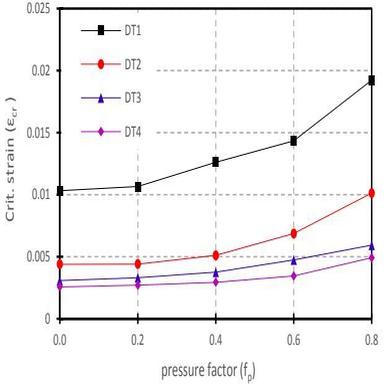
Plot of εcr vs. fp for RHT X52 pipe (PL/US = 0.81).